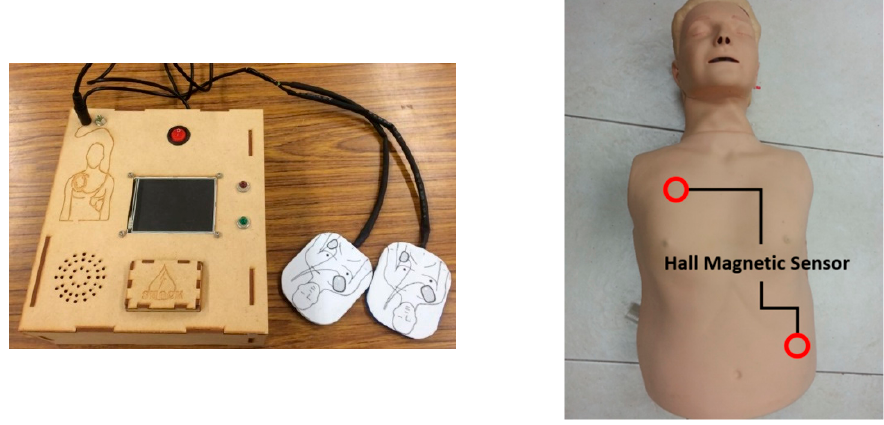
Figure 20. The self-designed AED and the sensor positions of the CPR manikin.